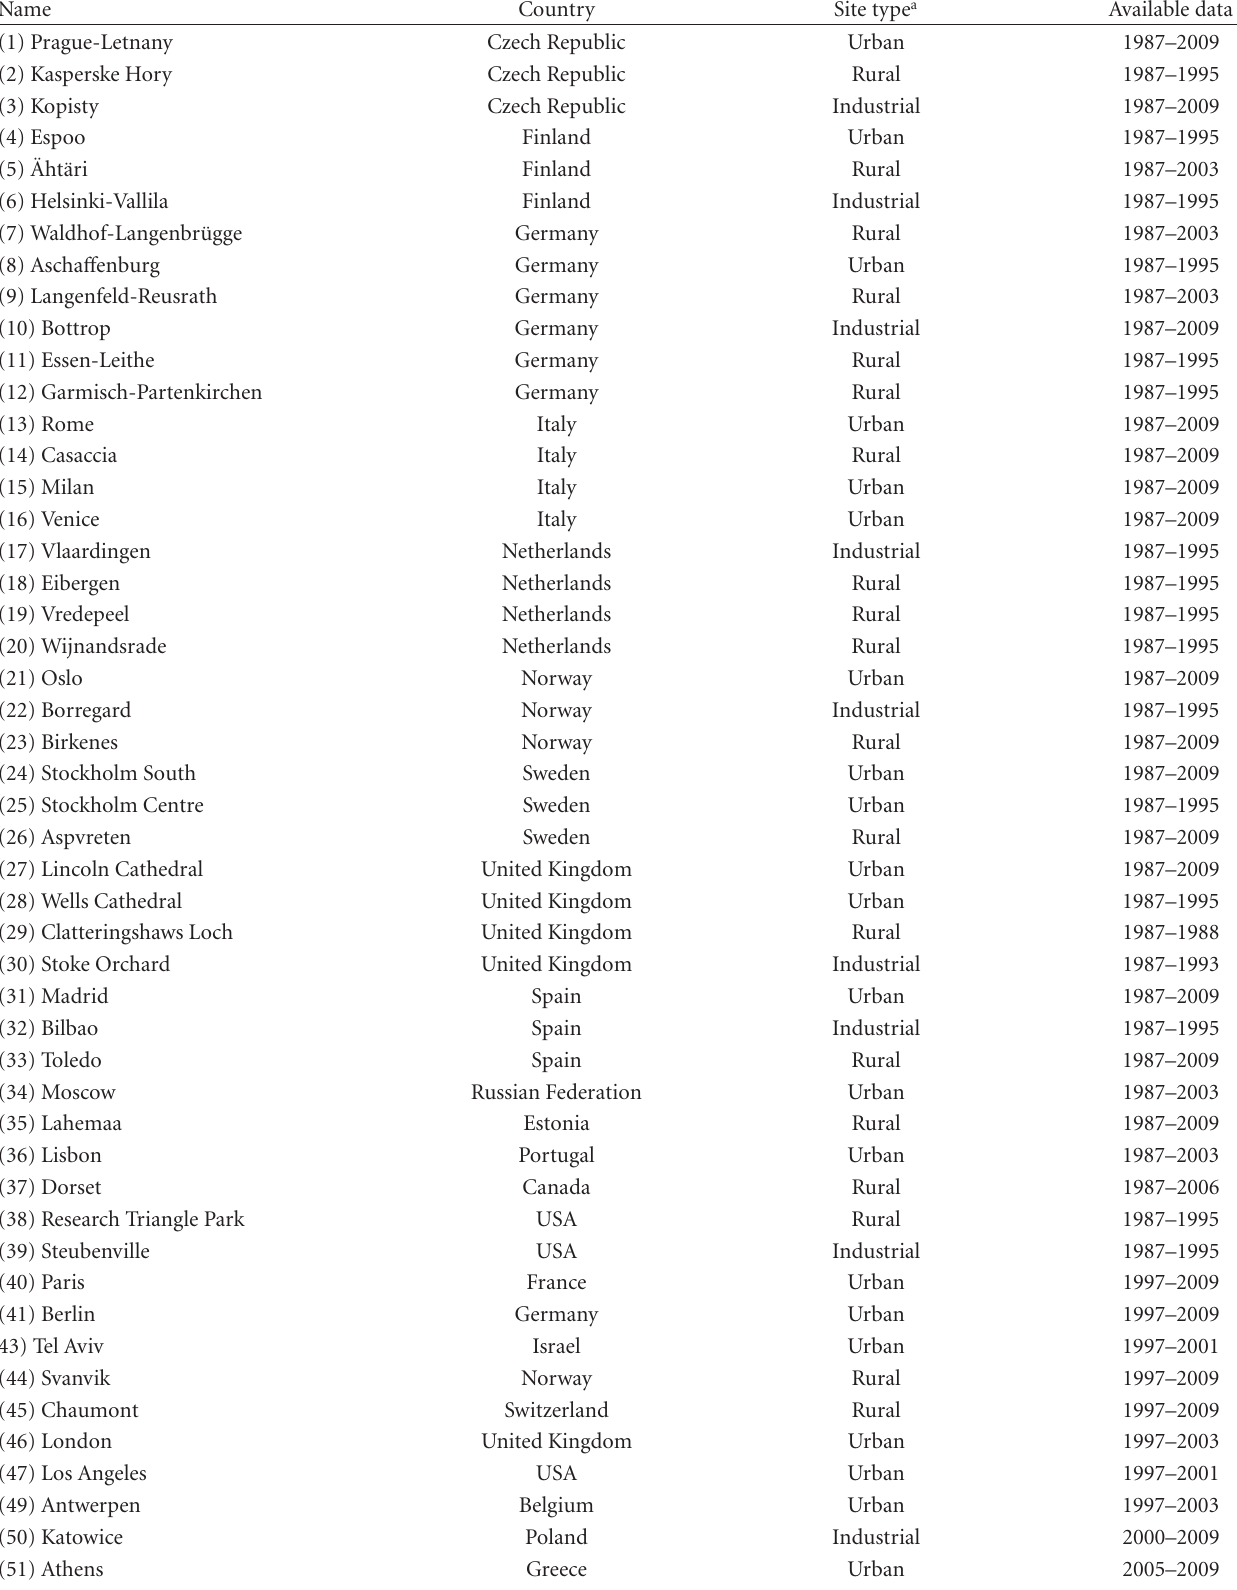
Table 1: List of ICP Materials test sites showing number, name, country site type, and years with available data